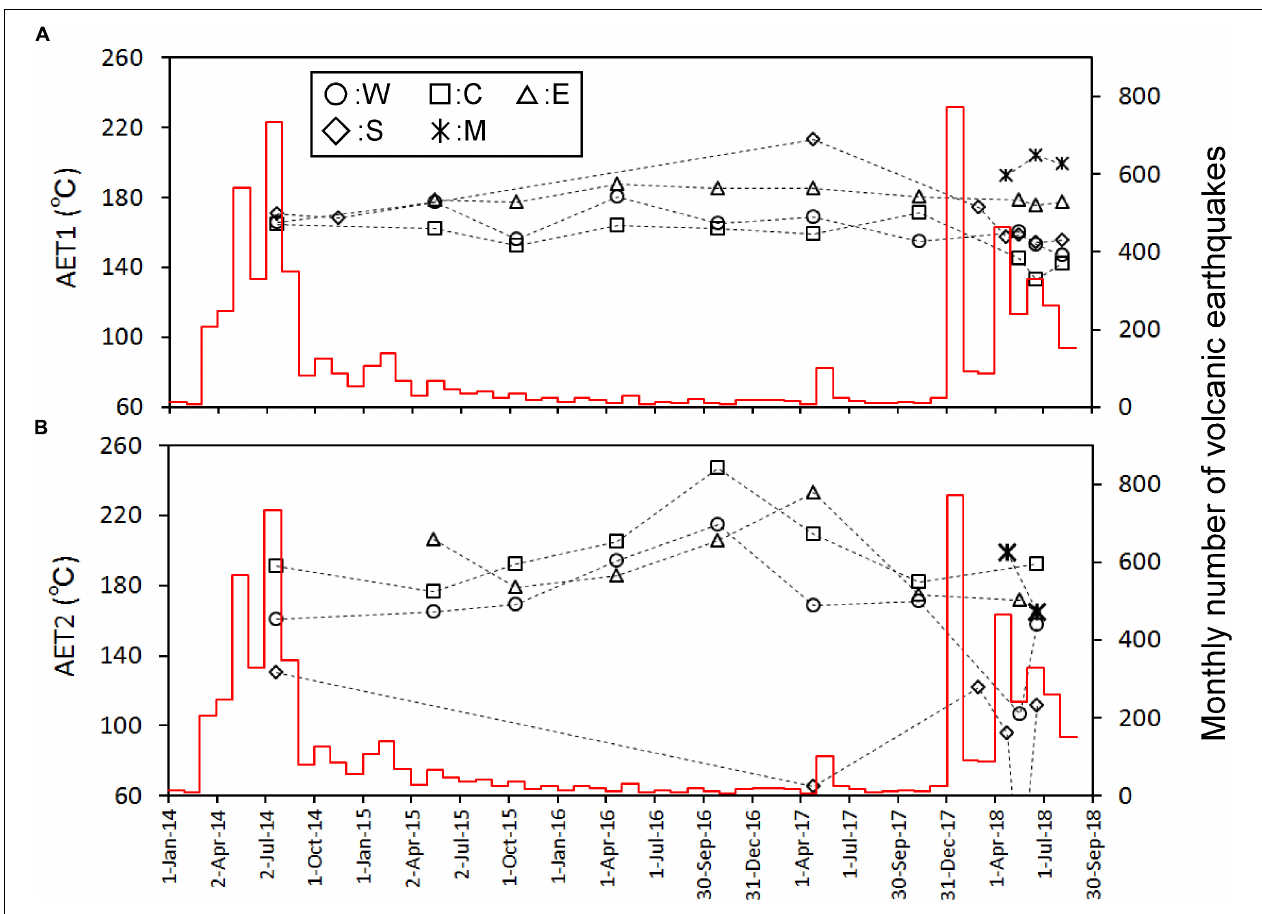
FIGURE 5 | Time variation of apparent equilibrium temperature [AET1 (A) and 2 (B) defined in the text] calibrated on the left y -axis. The red histogram calibrated on the right y -axis shows the monthly number of volcanic earthquakes observed by JMA.